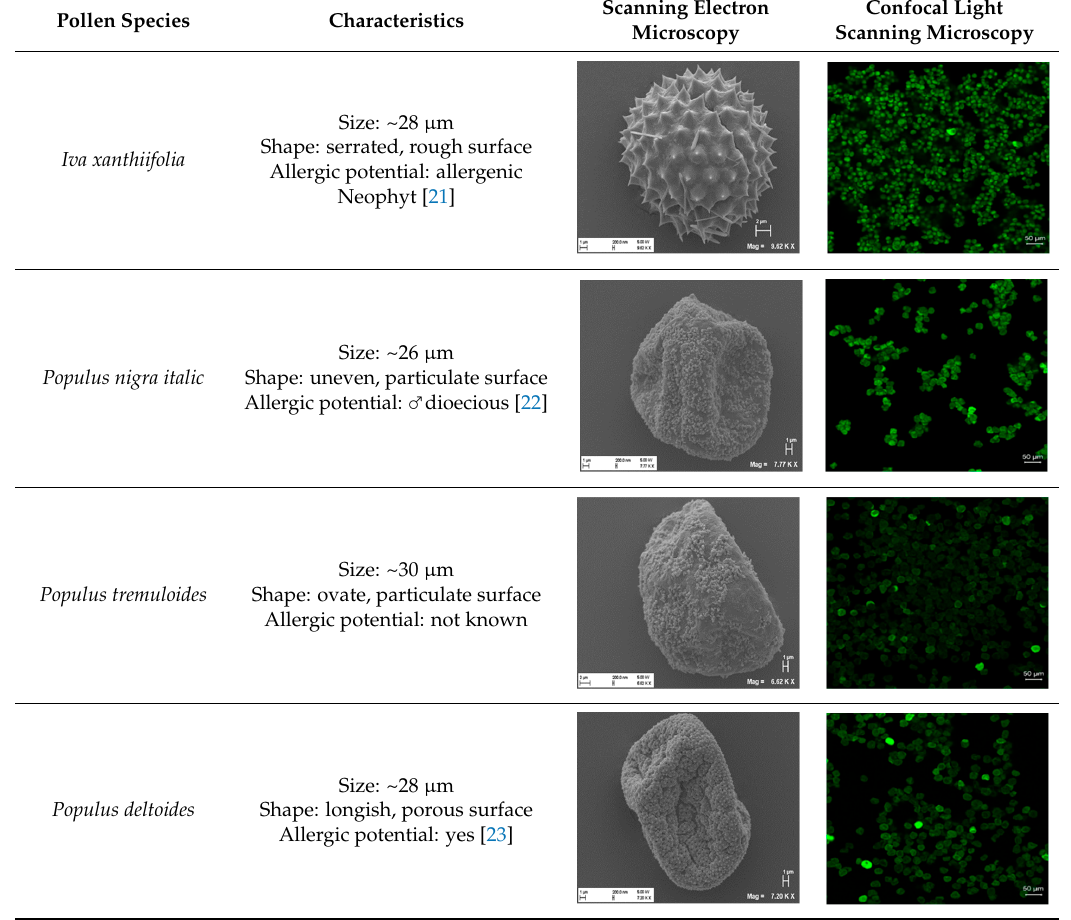
Table 1. Overview of the characteristics, size, shape, and autofluorescence of used pollen.